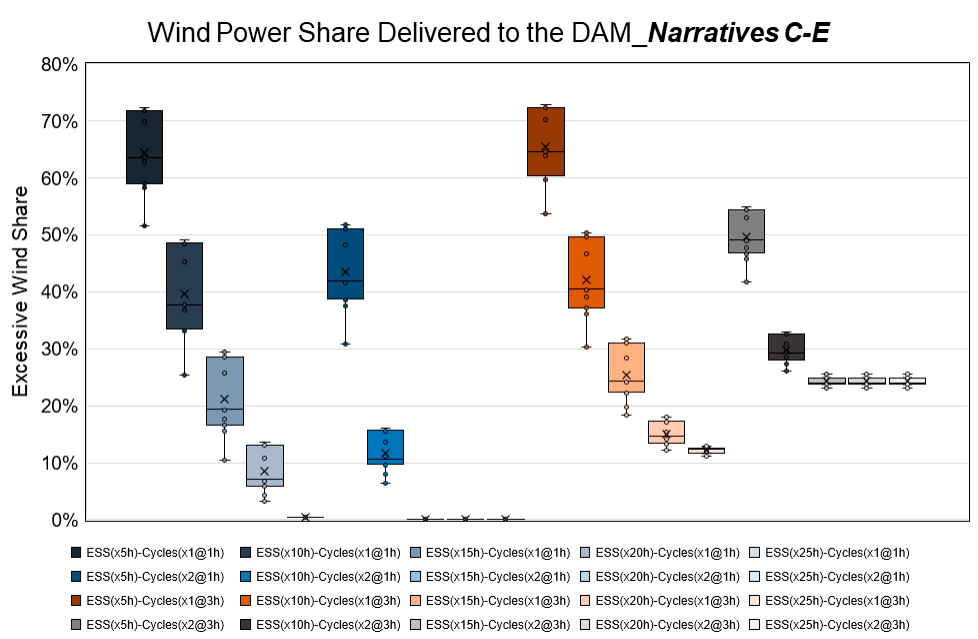
Figure 10. Shares of excessive wind power delivered to the market per di ff erent storage con fi gura- tion and cycling option, under the assumption of no dispatchability